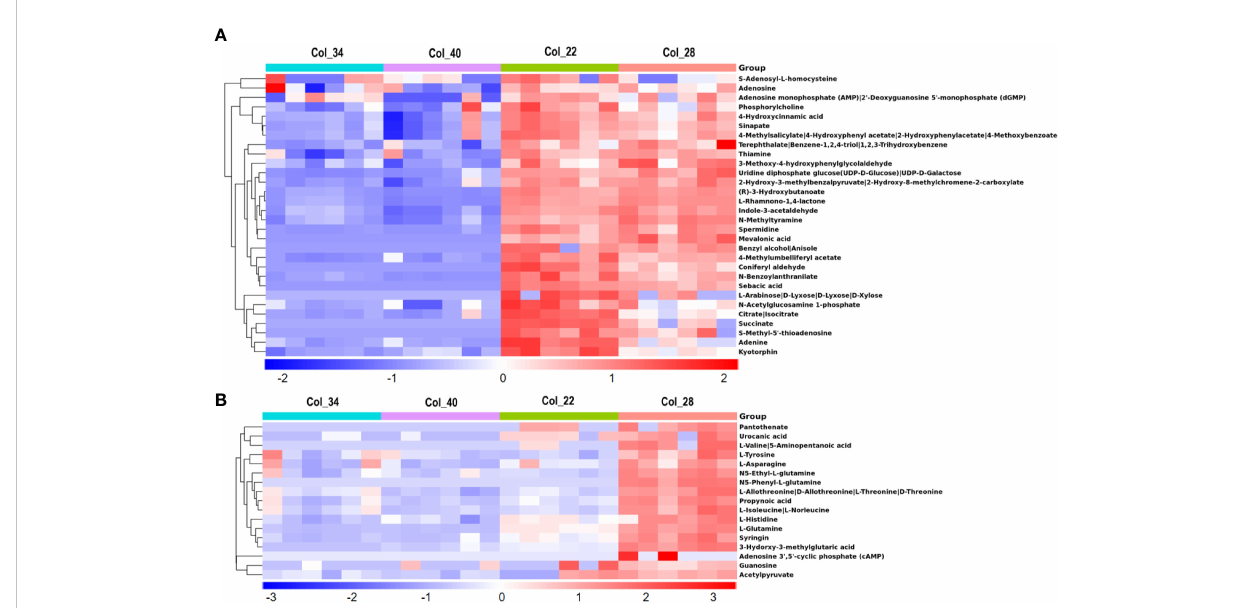
FIGURE 2 Comparative analysis of metabolites for Arabidopsis seeds germination/seedling growth between moderate and extreme high temperatures. (A) Heatmap showing Z score scaled the metabolites with higher level at moderate temperature (22°C, 28°C), compared with those at the extreme high temperature (34°C, 40°C). The relative enrichment of each metabolite in different samples were arranged in rows, and the relative levels of all metabolites in each sample were distributed in columns. The grids in heatmap represented metabolites, and shades of color represented relative level of metabolites. Red and blue colors indicate an increase and a decrease of metabolite level, respectively, and white color means no change. Col_22 means seeds germinated at 22°C, Col_28 means seeds germinated at 28°C, Col_34 means seeds germinated at 34°C, Col_40 means seeds germinated at 40°C. (B) Heatmap showing Z score scaled the metabolites with the highest level at 28°C, compared with other temperature conditions. The relative enrichment of each metabolite in different samples were arranged in rows, and the relative levels of all metabolites in each sample were distributed in columns. The grids in heatmap represented metabolites, and shades of color represented relative level of metabolites. Red and blue colors indicate an increase and a decrease of metabolite level, respectively, and white color means no change. Col_22 means seeds germinated at 22°C, Col_28 means seeds germinated at 28°C, Col_34 means seeds germinated at 34°C, Col_40 means seeds germinated at